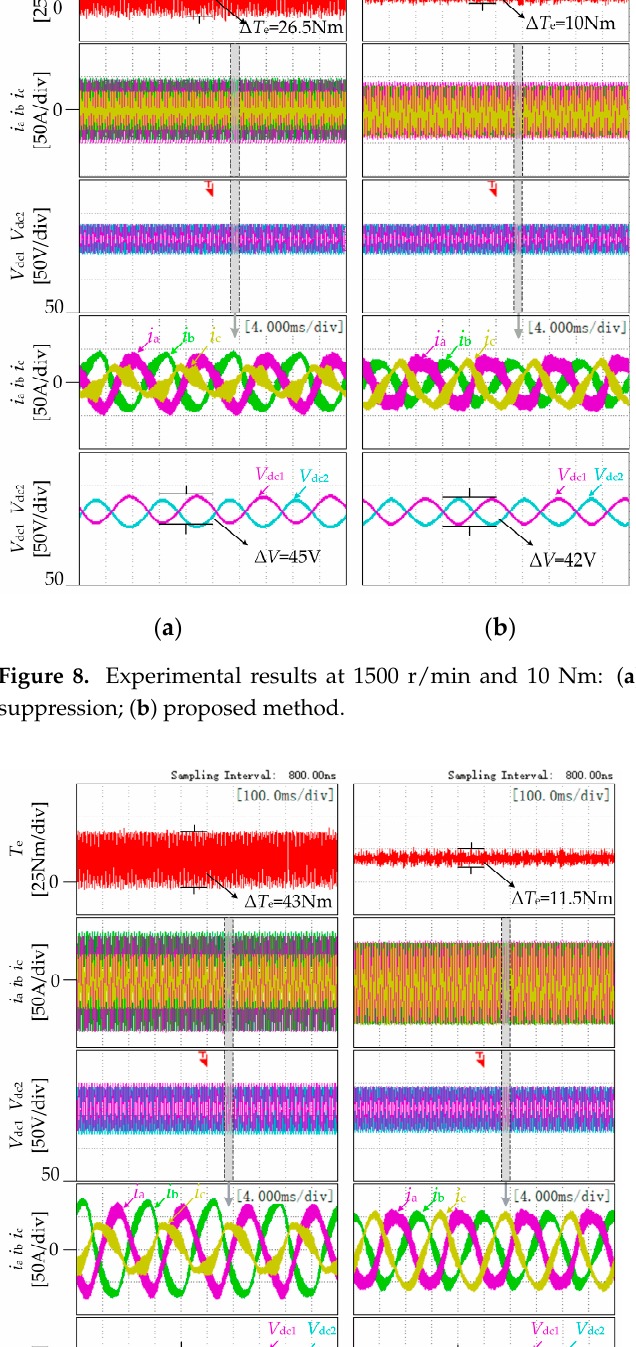
( b ) Figure 10 . Experimental results at 1500 r/min and 30 Nm: ( a ) without capacitor voltage offset sup- pression; ( b ) proposed method .